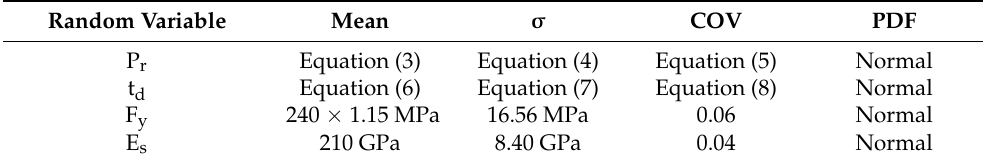
Table 1. Statistical properties of input random